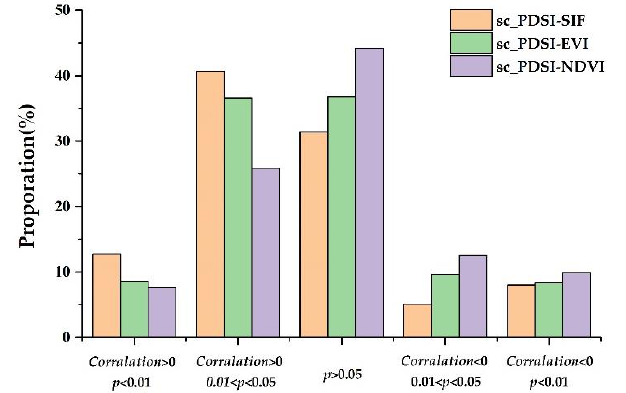
Figure 3. Correlation distribution of monthly average values in Yunnan Province from 2009 to 2011: ( a ) sc_PDSI & SIF; ( b ) sc_PDSI & EVI; ( c ) sc_PDSI & NDVI. (The numbers below the title are the range of values for this raster plot and the mean value).